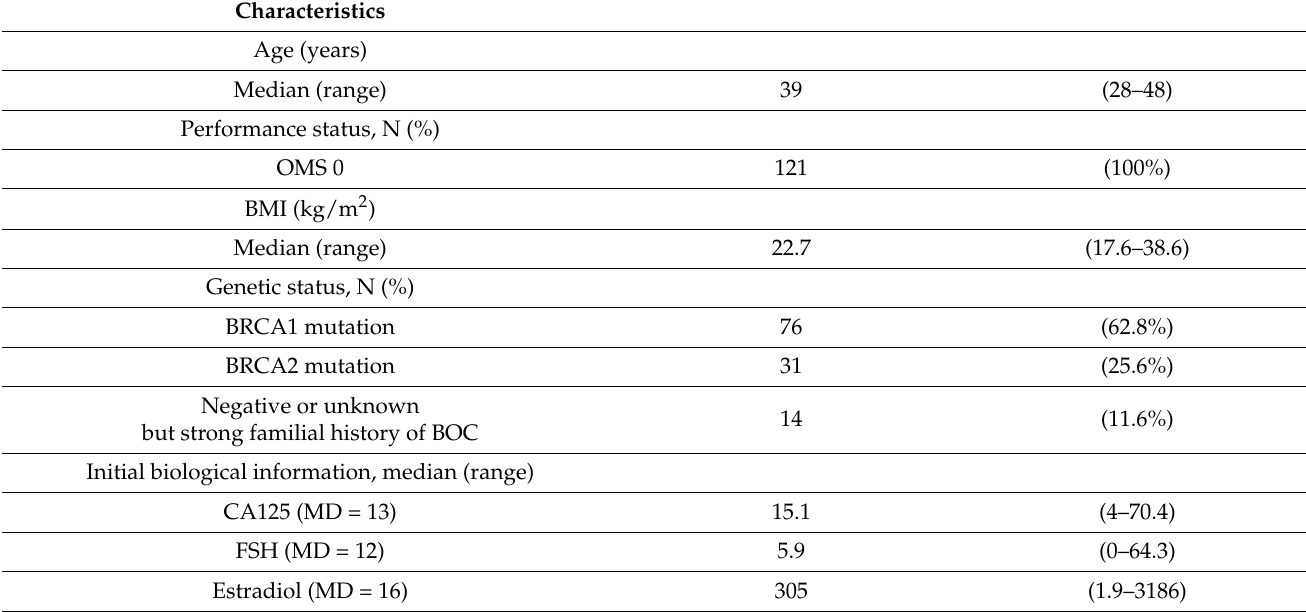
Table 1. Baseline characteristics (N =